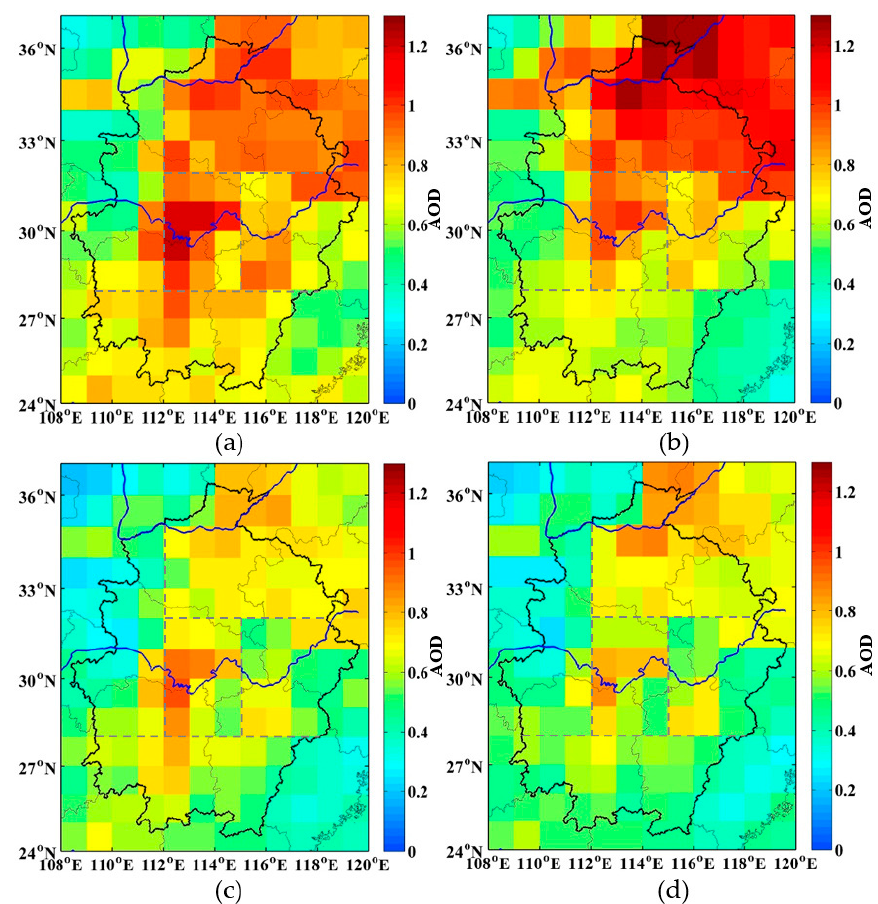
Figure 3. Seasonal mean AOD from 2001 to 2015 over central China: ( a ) spring, ( b ) summer, ( c ) autumn, and ( d ) winter.